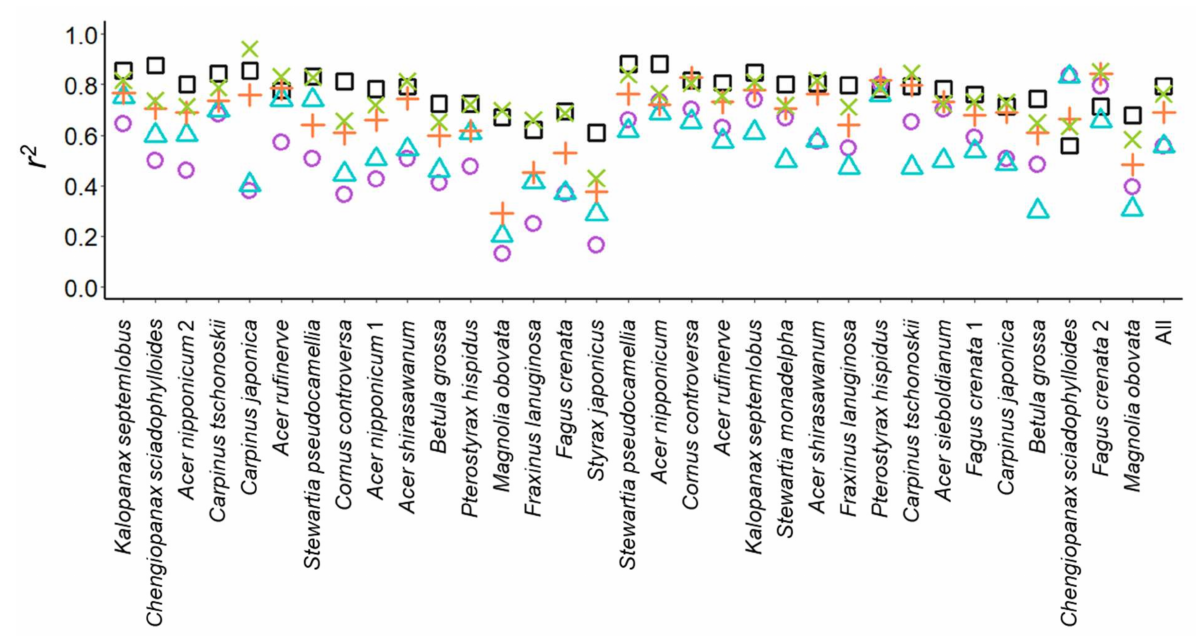
Figure 5. Comparison of the ability of leaf phenological metrics for predicting daytime sap flux density (SFD day ). We evaluated ability based on the root-mean-square error (RMSE) and coefficient of determination ( r 2 ) of the linear regression between the estimated SFD day values from Equation (6) and the measured values. The x -axis is sorted based on the measurement year and the RMSE values of crown leaf cover based on the ground observation (CLC ground ). All regressions showed significant cor- relations ( p < 0.001). The data used for the regression analysis are shown in Figure A7. Abbreviations: GCC, green chromatic coordinate; GEI, green excess index; GRVI, green-red vegetation index. For a more detailed comparison of phenology between leaf and sap flow, we re- produced the optimized SFD day (SFD opt ) using Equations (6) and (7) and compared the phenological transition dates of SFD opt and leaf phenological metrics (Figure 6). The SOR derived from the leaf phenological metrics was significantly correlated with that derived from SFD opt irrespective of the type of metric, with an RMSE of less than seven days. However, the RMSE values of the correlations increased as spring progressed, and signifi- cant correlations disappeared in comparison with the EOR. In contrast, in the decreasing phase, the RMSE values of the correlations decreased as the seasons progressed. Only the transition dates derived from CLC ground and Hue were significantly correlated with those derived from SFD opt throughout the decreasing phase.